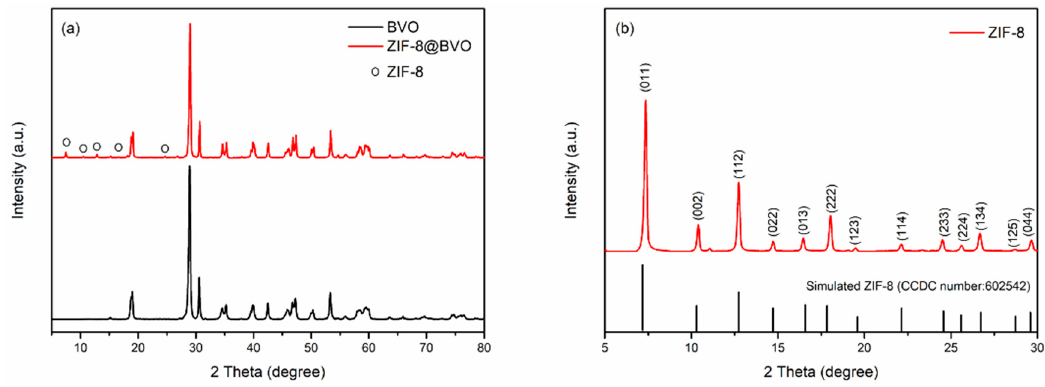
Figure 1. XRD pattern of ( a ) BiVO 4 (BVO) and ZIF-8@BVO, ( b ) ZIF-8. ZIF: zeolitic imidazolate framework; ZIF-8@BVO: ZIF-8–BVO composite photocatalyst.